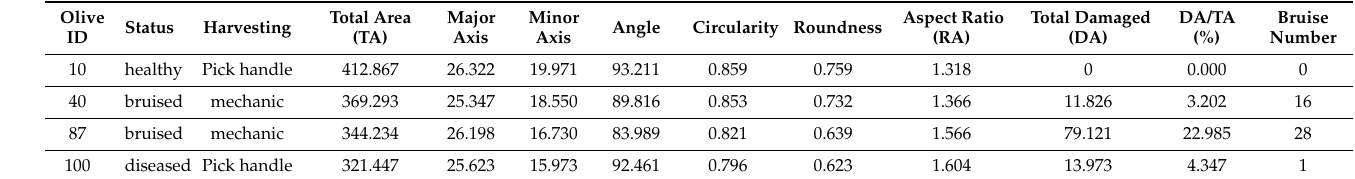
Figure 2. Bruise detection spot from image analysis workflow. Olive variety Hojiblanca: ( a ) original photographs, ( b ) ROI image cropped, ( c ) split color channels, ( d ) green (bruise spot) and blue (whole olive) channels for segmentation, ( e ) segmented images, and ( f ) results of image analysis. Table 2. Example of results obtained from image